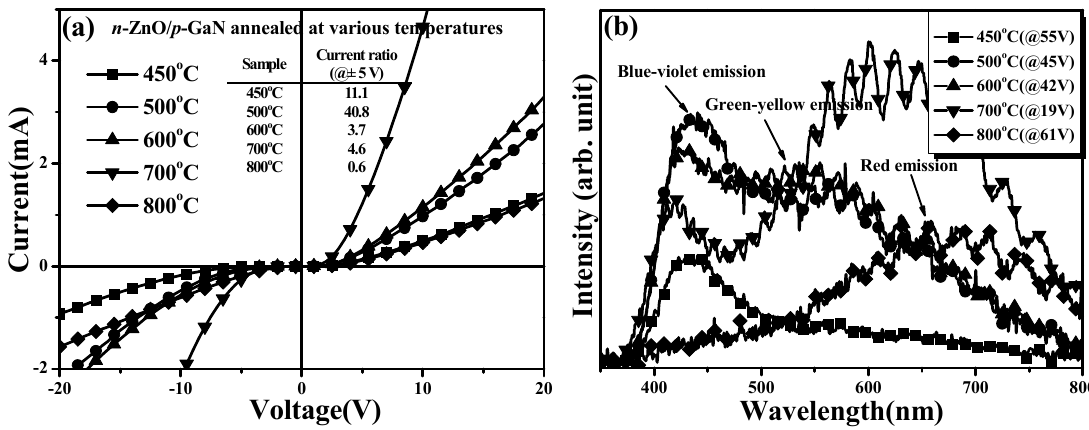
Figure 3. ( a ) Current ‐ voltage (I ‐ V) characteristics of diodes fabricated using n ‐ ZnO/ p ‐ GaN heterojunction structures annealed at temperatures of 450, 500, 600, 700, and 800 °C, respectively, under vacuum atmosphere for 30 min and ( b ) electroluminescence (EL) spectra of these diodes measured under an injection current of 20 mA.